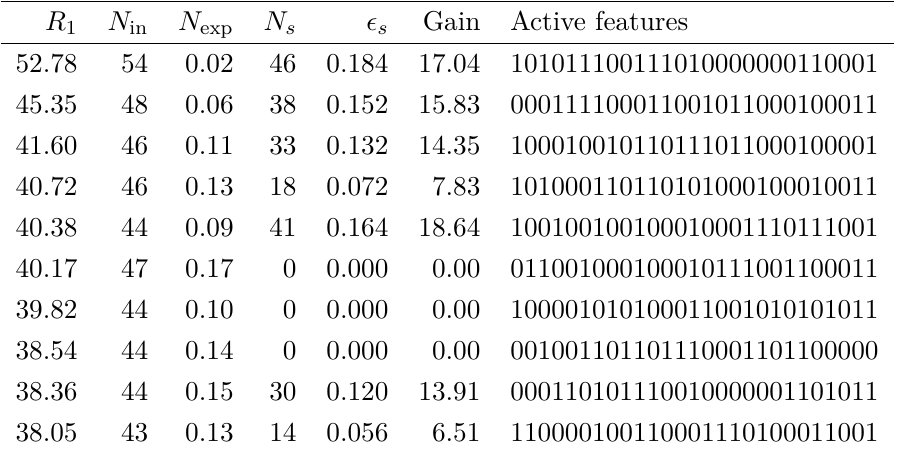
Table 3 . Results of an exploratory RanBox search on the HEPMASS dataset with a 5% signal contamination; data for the 10 most significant boxes are reported. N indicates the number of s signal events in the search box; (cid:15) is the efficiency of the box selection for the signal component; s gain is computed as the increase in the signal fraction of the box over the initial dataset. For other detail see the text.